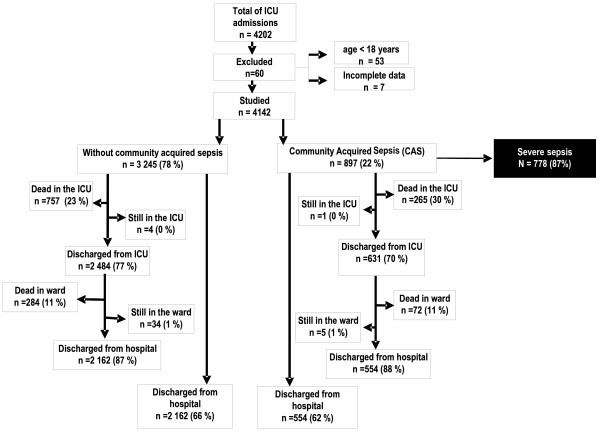
Flow diagram of enrolled patients.